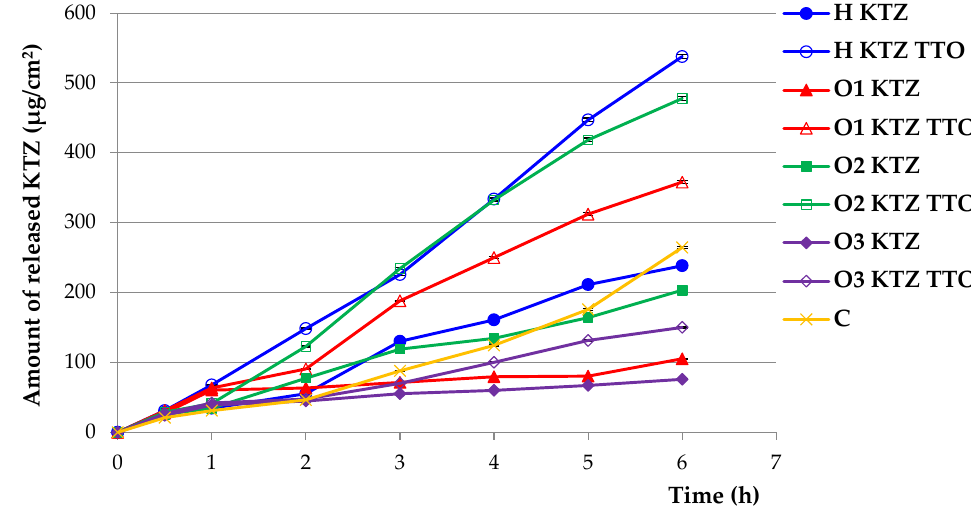
Figure 4. In vitro release of KTZ from prepared PLU ® F-127 hydrogels, PLO organogels, and commercially available product (C). Values are expressed as means ± SD of six replicates; p < 0.05.